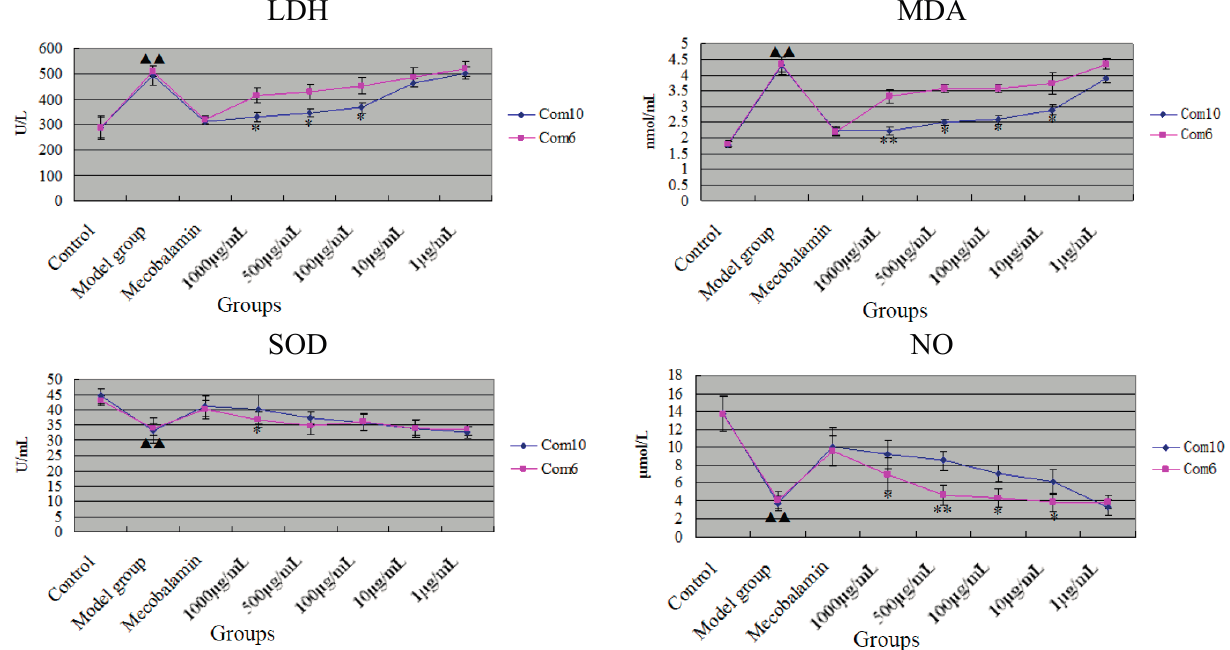
Figure 6. Combination 6 and combination 10 acting on human umbilical vein endothelial cells (HUVEC) under high concentration of glucose. The differences of LDH and